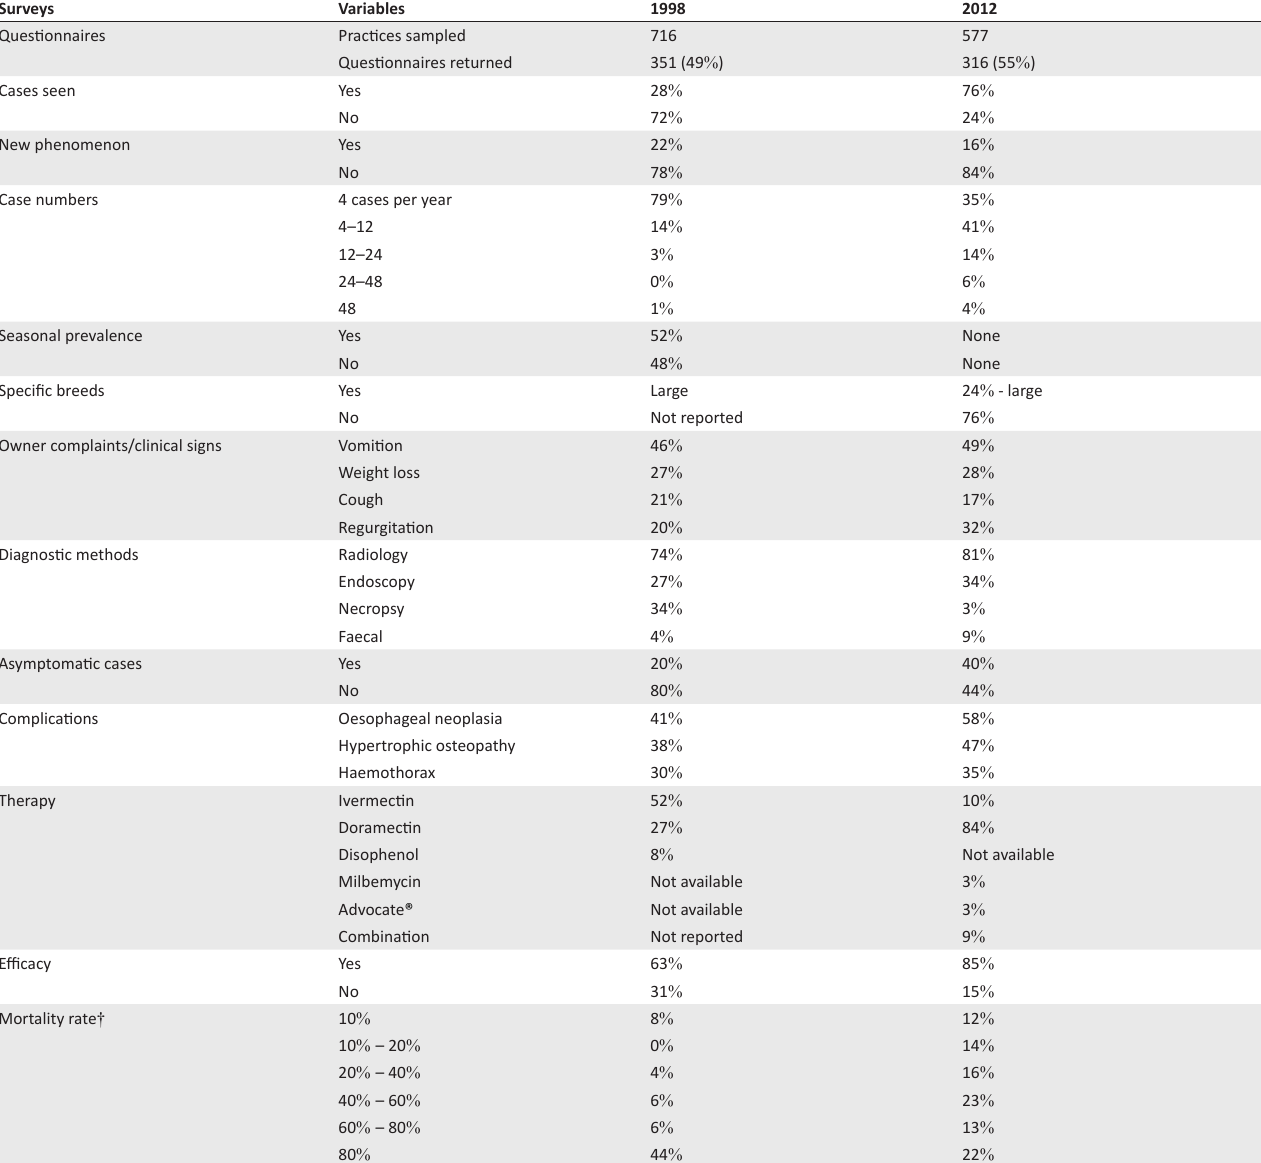
TABLE 1: Comparison between the 1998 and 2012 surveys. Surveys